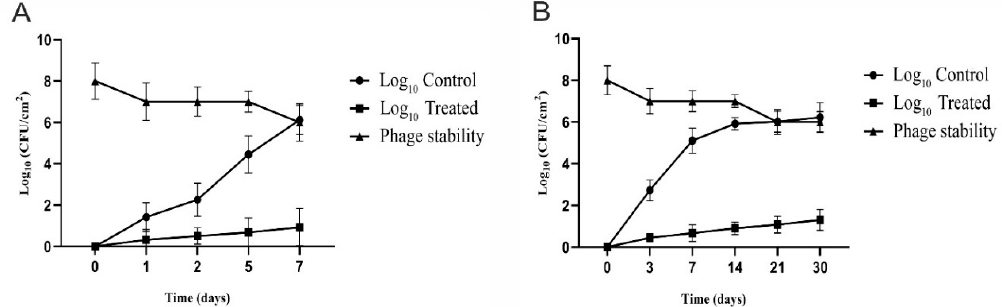
Figure 8. Biocontrol efficacy and stability of CoNShP-3 phage in artificially inoculated food by CoNS bacteria ( S. haemolyticus CFS43 and S. epidermidis CFS79). ( A ) Short term storage and stability (7 days) at 4 °C. ( B ) Long term storage and stability (1 month) at − 20 °C.